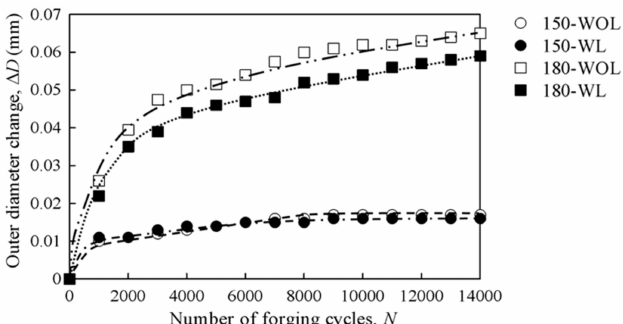
Figure 13. Variation in the specimen outer diameter change (near the working surface) by number of forging cycles. (150 / 180—Forging load (kN), WL—With Lubrication, WOL—Without Lubrication).